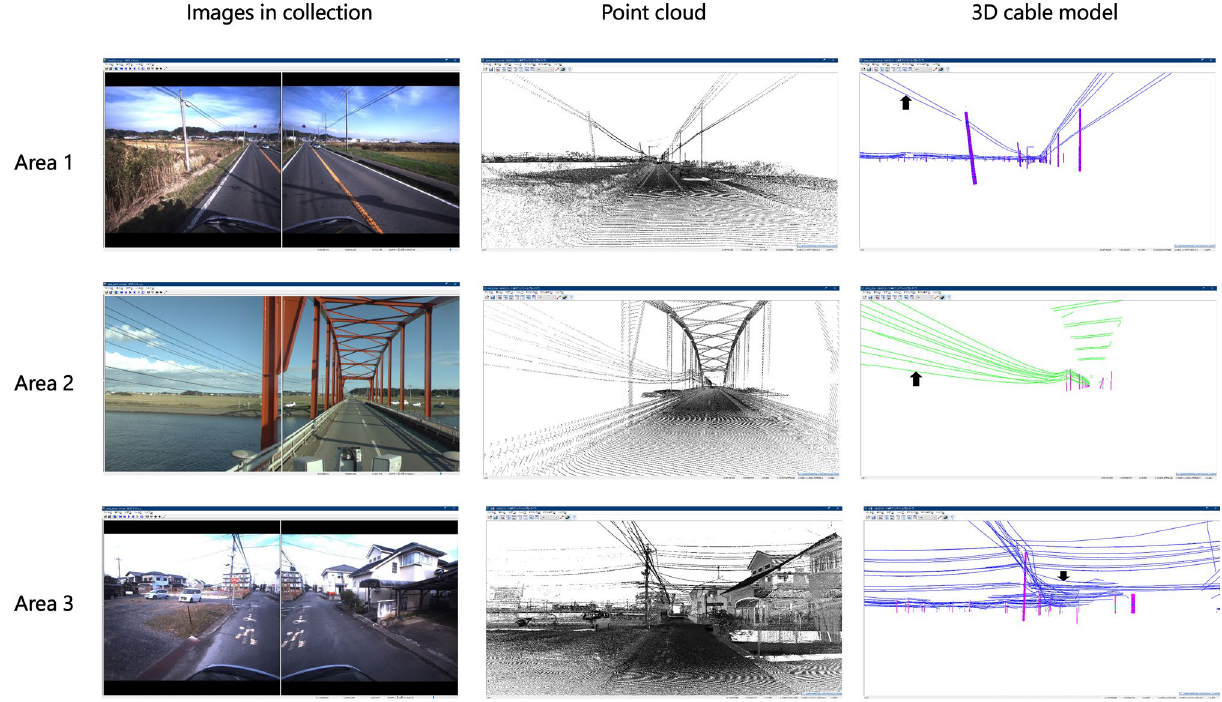
Fig. 8 Traversed area in captured images, point cloud, and 3D cable